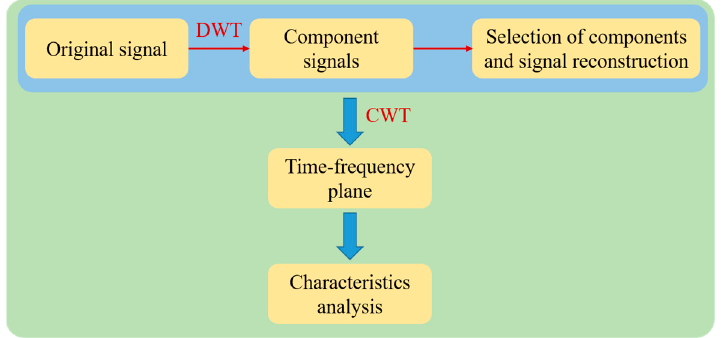
Figure 3. Time-frequency analysis process.